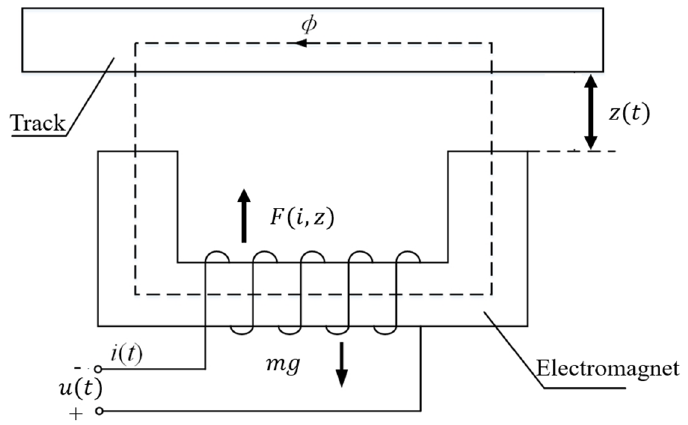
Figure 2. The single point suspension model.